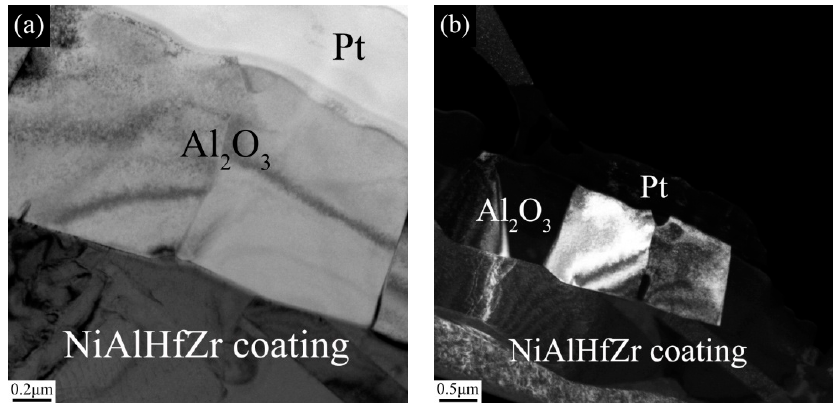
Figure 8. Transmission electron microscopy (TEM) bright field image ( a ) and dark field image ( b ) of Al 2 O 3 scale grown on the Hf/Zr co-doped coating after 100 h cyclic oxidation at 1150 °C.